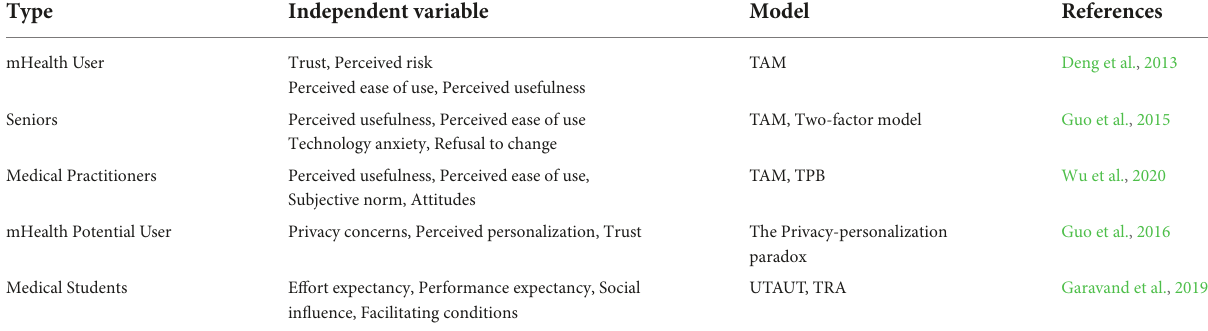
TABLE 1 Research related to mHealth adoption